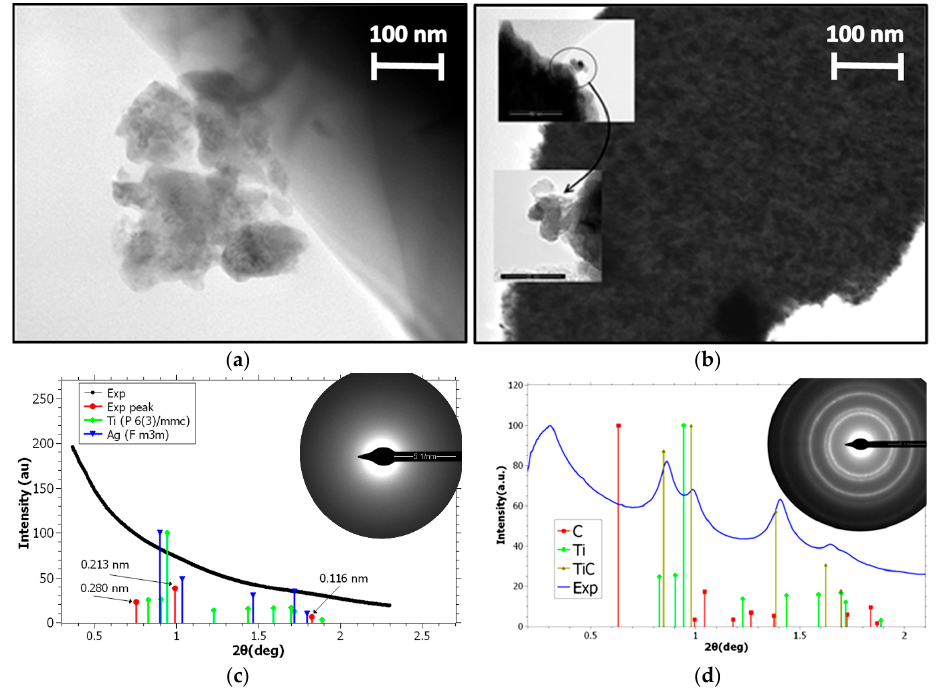
Figure 7. TEM images (( a ) Ti-Ag/Si, ( b ) Ti-C/Si) and SAED profile (( c ) Ti-Ag/Si, ( d ) Ti-C/Si) of the binary thin films. Table 3. Contact angle and free surface energy measurements. Table 3. Contact angle and free surface energy